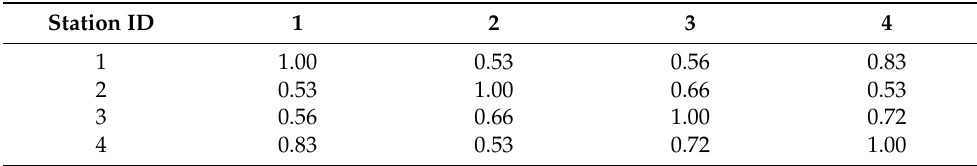
Table 2. Section correlation analysis